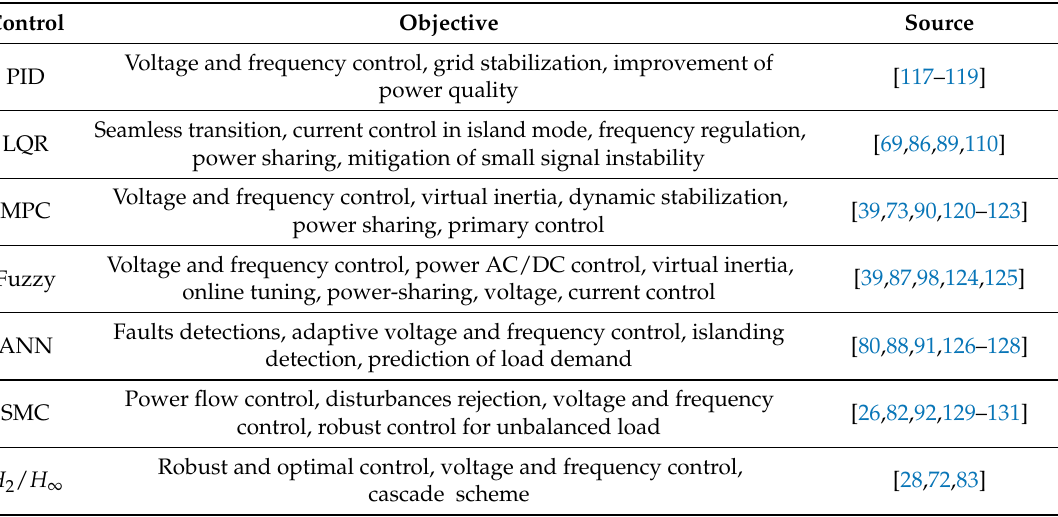
Table 4. Resume of advanced controllers